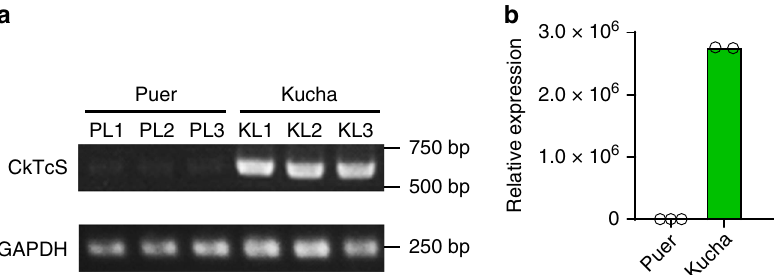
Fig. 3 Transcriptional level analysis of CkTcS gene in Kucha and Puer. a Qualitative analysis of CkTcS and GAPDH expression in Puer and Kucha. PL1, PL2, PL3, and KL1, KL2, KL3 represent three different leaves from Pure tea plant and Kucha tea plant, respectively. b Quantitative analysis of CkTcS and GAPDH expression in Puer and Kucha by quantitative real-time PCR. The gene expression in each leaf was analyzed at three replicates. The PCR was run for 40 cycles. Expression of CkTcS relative to GAPDH in three Pure leaves versus two Kucha leaves is